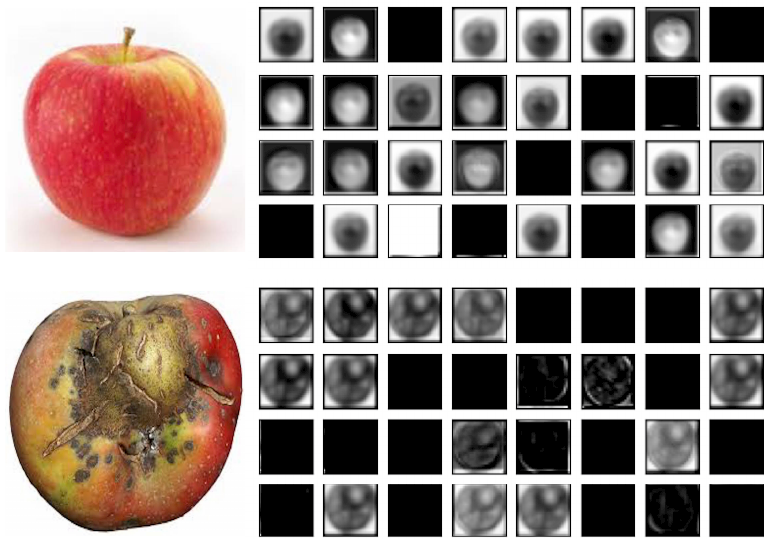
Figure 15. Examples of activation maps of the 3rd convolution layer for two images from Apple-NDDA dataset [104].